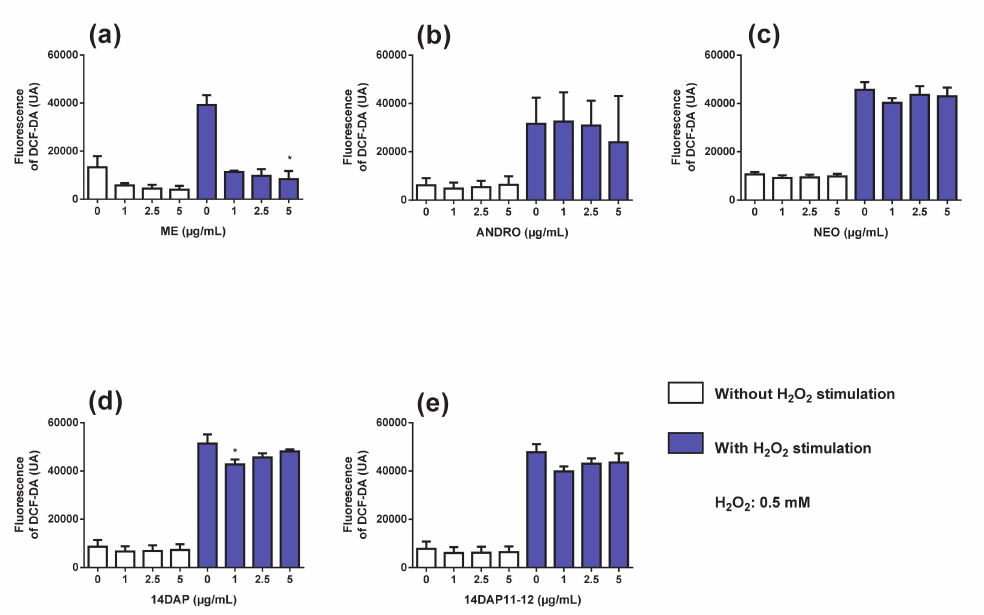
Figure 4. E ff ect of ME, ANDRO, NEO, 14DAP, and 14DAP11-12 on oxidative stress. HDFa were treated with increasing concentration (1, 2.5 or 5 µ g / mL) of ME ( a ), ANDRO ( b ), NEO ( c ), 14DAP ( d ), or 14DAP11-12 ( e ) for 1 h. The control cells were treated with 0.05% DMSO. ROS production was induced by 0.5 mM H 2 O 2 and free radical scavenging activity was done using a DCFH-DA probe. The values mean ± S.D. * p < 0.05 compared with control group, n =